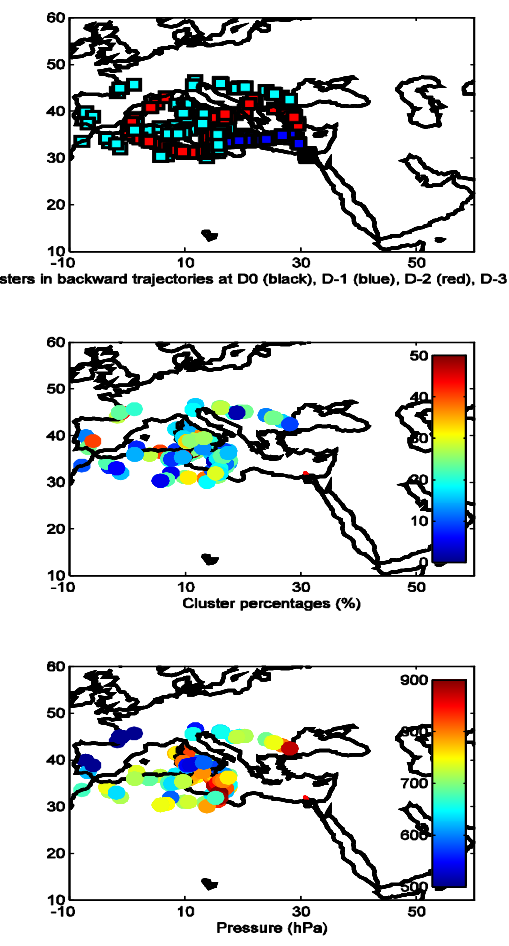
Fig. 5. Backward integration in time for 3 days for the MOZAIC vertical profile measurements and for air masses arriving at 1500– 5000m over Cairo during a period with low ozone levels in the lower troposphere (26 July 2002, Flight: MD20020726023). The results are summarized on centroids of 5 clusters, and include every 12h latitude, longitude, pressure and percentage of representation. The results shown above are for the 1.5–5km layer. Top plot shows the clusters positions at day 0 (black), day-1 (blue), day-2 (red), and day-3 (cyan). The middle plot shows the percentages of clusters at day-3. Finally, the bottom plot shows the pressure of the clusters at day-3. The red line is the aircraft trajectory during ascent/descent.